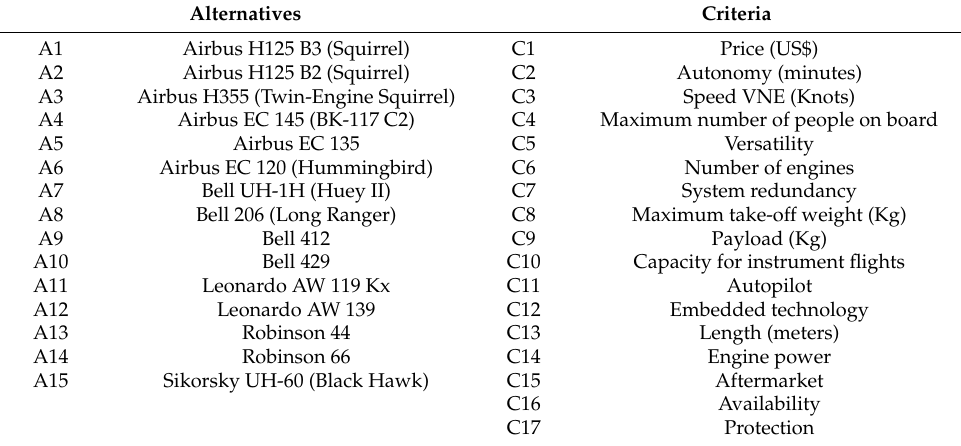
Table 1. Alternatives and criteria established for